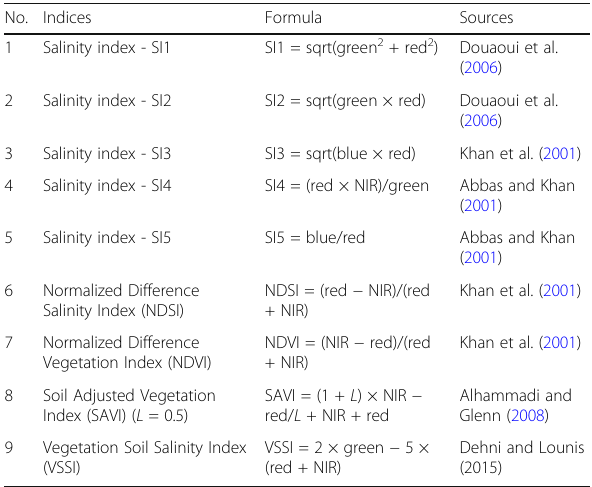
Table 2 The formulas used to derive the indices, and their